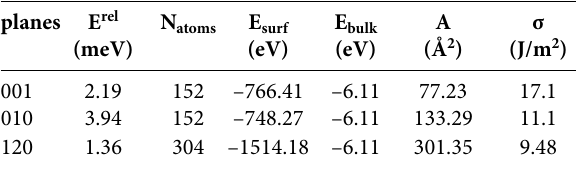
Table 2. Relative crystal plane parameters of crystal planes easily exposed when PVP is not